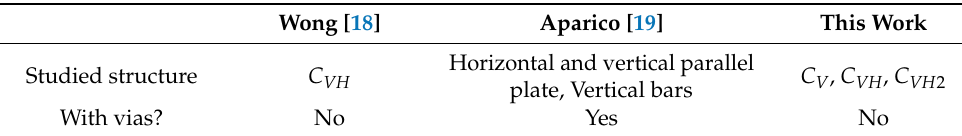
Table 3. Comparison with the previous studies